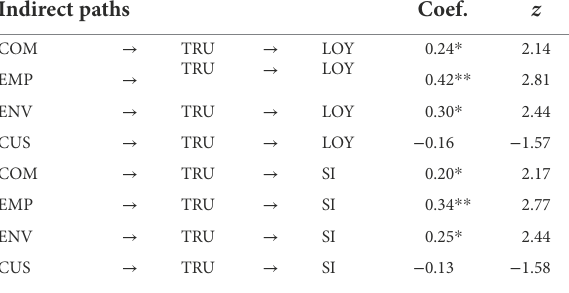
TABLE 5 Indirect effects of the SEM results. Indirect paths